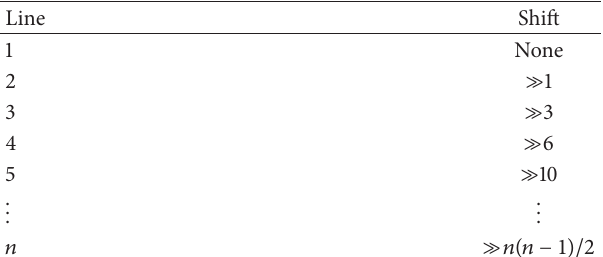
Table 2: Steganography data shift rules. Line